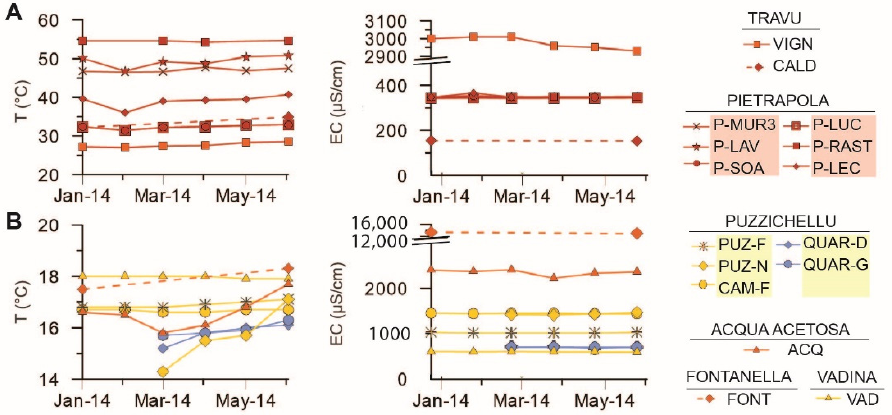
Figure 2. Time evolution of physico-chemical parameters (T and E.C.) of groundwater, discriminated as thermal ( A ) and cold ( B ) waters (N = 92).